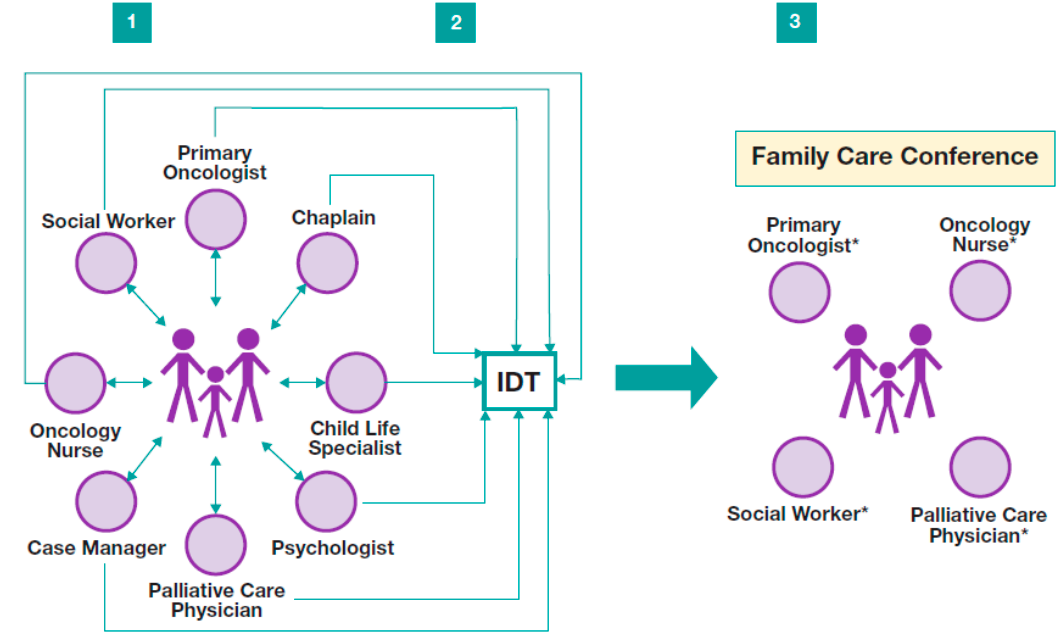
Figure 2. Flowchart demonstrating ideal collaborative efforts to promote effective communication of comprehensive care plans. Panel 1 illustrates individual interdisciplinary team (IDT) members meeting with patient and family; Panel 2 illustrates the IDT meeting; and Panel 3 illustrates the family care conference conducted based on recommendations from the IDT meeting. IDT members will be chosen to participate in the family conference based on the information to be discussed and the needs of the patient and family.